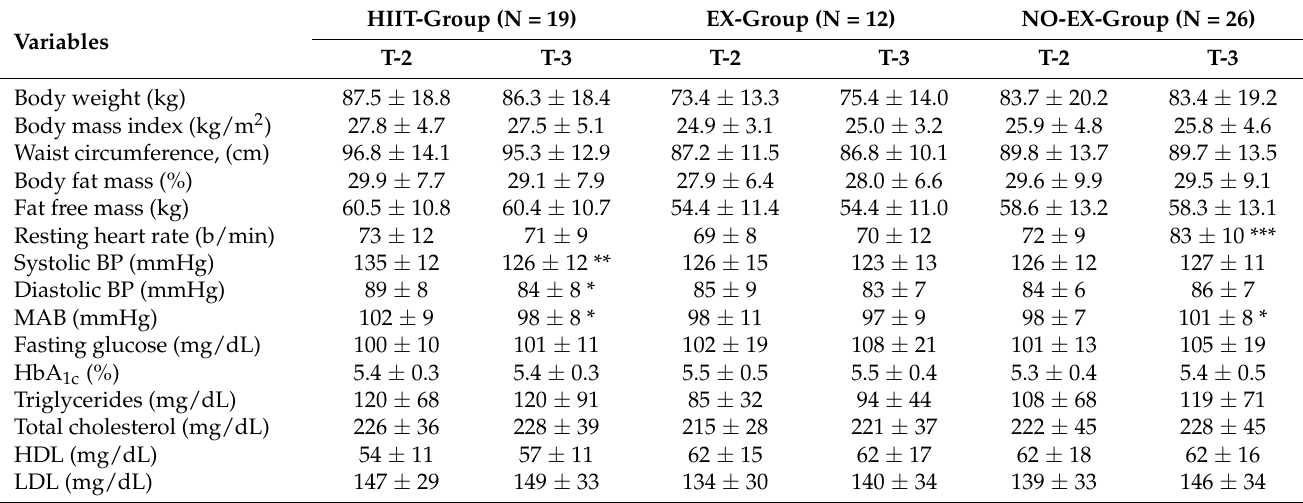
Table 6. Mean values and standard deviations (SD) of participants’ (N = 57) body composition and cardiometabolic data at post-intervention (T-2) and follow-up (T-3).